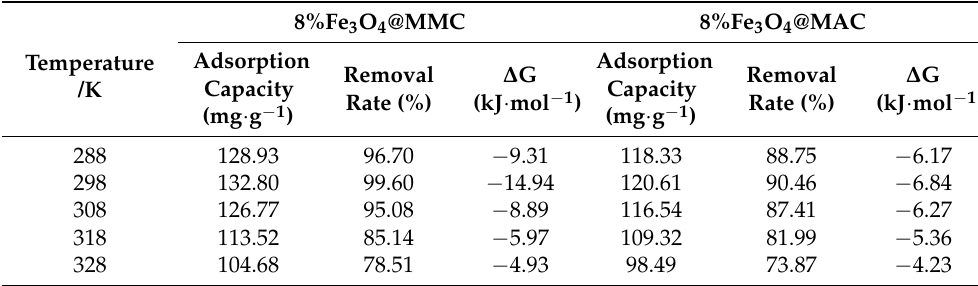
Table 7. Effect of temperature and the Gibbs free energy change at different